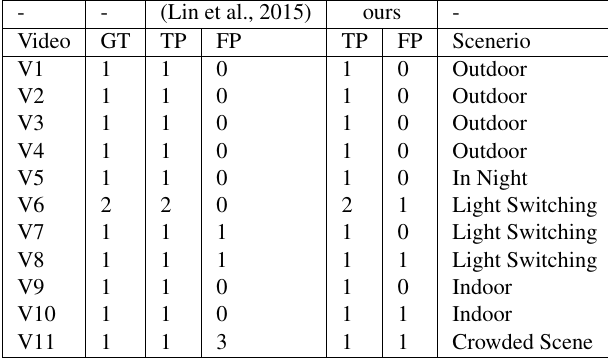
Table 2: Comparison of different methods on ABODA. GT,